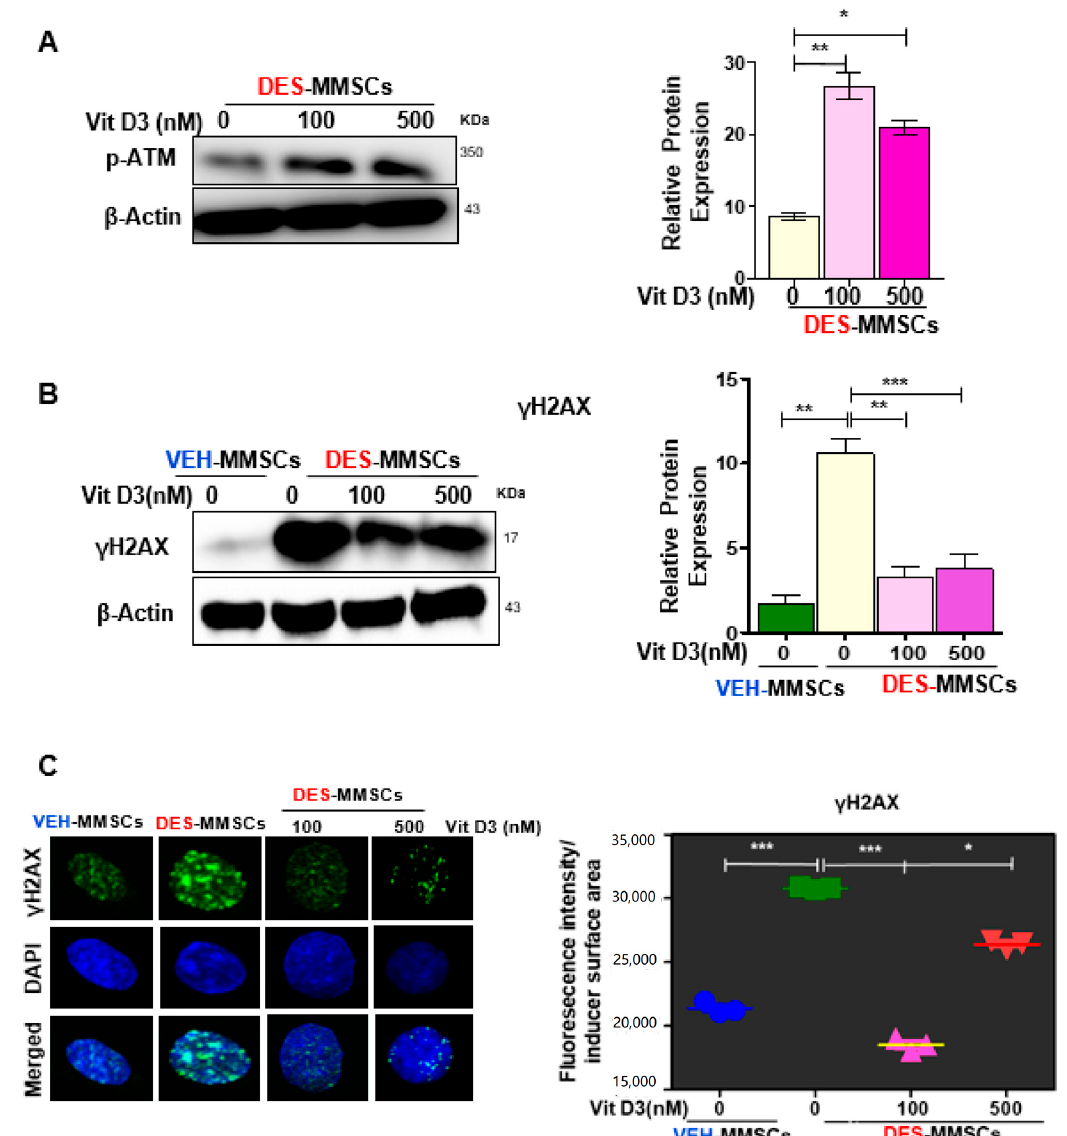
Figure 2. VitD3 reverses the impairment of DNA repair capacity in DES-exposed myometrial stem cells (DES-MMSCs). ( A ) The left panel shows the Western blot of p-ATM in DES-MMSCS with and without VitD3 (48 h), where β -actin was used as a loading control. The right panel shows the corresponding data graph created using relative data. ( B ) The protein levels of the DNA damage marker H2AX in MMSCs were determined by Western blot analysis. VitD3 (48 h treatment) protected DES-MMSCs from double-strand breaks (DSBs) and promoted DSB DNA repair (left panel). Relative data were used to create the corresponding data graph (right panel). ( C ) The left panel shows immunofluorescence staining of the γ H2AX antibody in VEH- and DES-MMSCs with and without VitD3 treatment using confocal laser microscopy. The right panel shows single γ -H2AX foci altered fluorescence intensity per nuclear area assessed by Image J. Quantification of nuclear γ H2AX intensity was used to compare DES-MMSCs with VEH-exposed MMSCs (VEH-MMSCs) and to compare VitD3 treatment at 100 and 500 nM with untreated DES-MMSCs. Two-tailed unpaired Student’s t -tests were used. Experiments were performed in triplicate and repeated twice with n = 3 biological replicates. All graphs show mean ± SEM with * p < 0.05, ** p < 0.01, *** p <